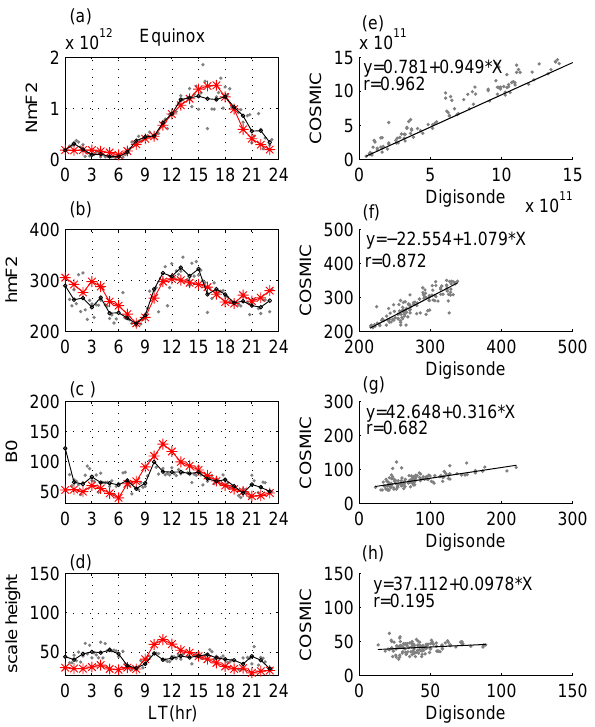
Fig. 4. (a) – (d) Comparison of the diurnal variations obtained from ground-based observations (red asterisk) and RO measurements (circled line) and (e) – (h) scatter plots for the Nm F2, hm F2, B 0, and H T parameter in the